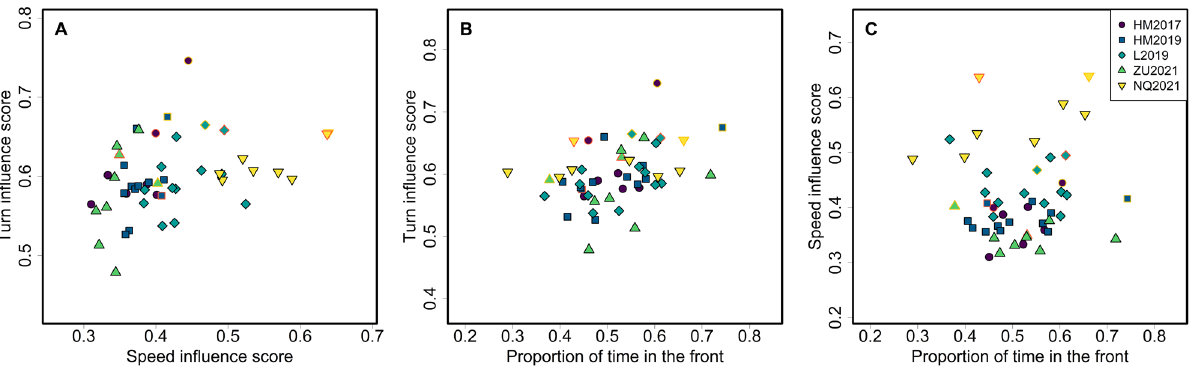
Figure 4. Pairwise associations between turn influence scores, speed influence scores, and proportion of time spent in the front half of the group. Each point represents one individual, with color and shape indicating group membership. Dominant females and dominant males are indicated by yellow and orange borders, respectively. ( A ) Turn influence vs. speed influence. ( B ) Turn influence vs. proportion of time spent in the front. ( C ) Speed influence vs. proportion of time spent in the